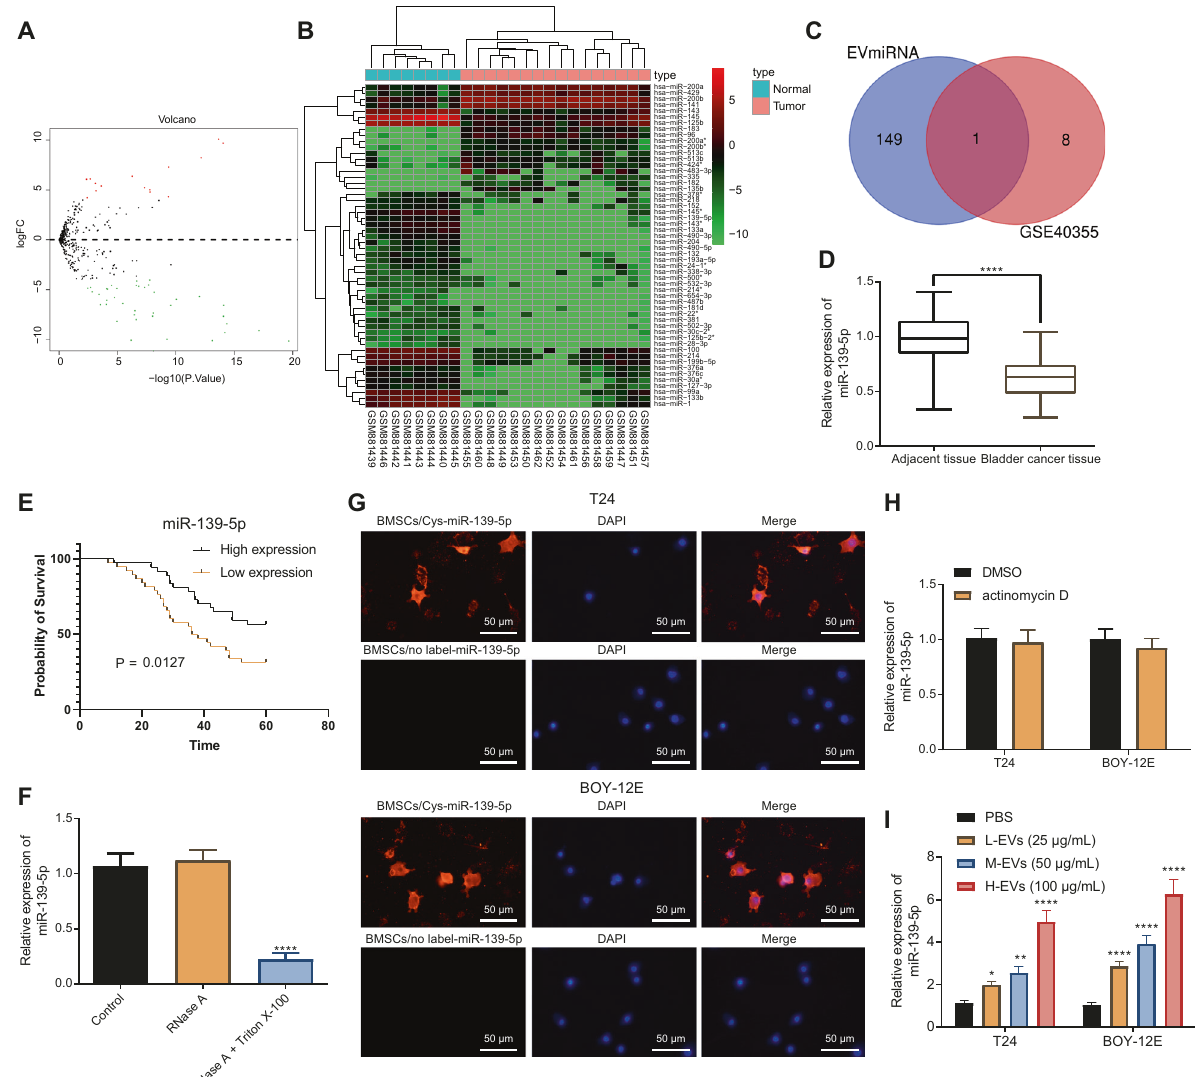
Fig. 2 BMSCs-EVs deliver miR-139-5p into bladder cancer cells. A A volcano map of miRNA differential expression in the GSE40355 dataset. The black part indicates the miRNA with no signi fi cant difference in bladder cancer, the green represents the miRNA that was signi fi cantly downregulated in bladder cancer, and the red represents the miRNA that was signi fi cantly upregulated in bladder cancer. B A heat map of expression of the 15 most signi fi cantly upregulated and 39 most downregulated miRNAs in the GSE40355 dataset. C Screening of miRNAs that were signi fi cantly downregulated in bladder cancer and expressed in BMSCs-EVs. The left circle represents the top 150 miRNAs of EVmiRNA query results, the right circle represents the top 10 miRNAs signi fi cantly downregulated in GSE40355 dataset, and the middle part represents the intersection of the two groups of data. D The expression of miR-139-5p in bladder cancer tissues and the adjacent normal tissues measured using RT-qPCR ( n = 75). **** p < 0.0001. E The relationship between the survival rate of bladder cancer patients and miR-139-5p expression in bladder cancer tissues analyzed by the Kalpan-Meier method ( n = 75). F The expression of miR-139-5p in the BMSC culture medium after the addition of RNase A alone or RNase A and Triton X-100 co-addition to treat EVs tested using RT-qPCR. **** p < 0.0001. G The uptake of Cy3-labeled BMSCs-EVs-miR-139-5p (red fl uorescence) by T24 and BOY-12E cells was observed by a fl uorescence microscope. The cytoplasm stained with DAPI shows blue (Scale bar = 50 μ m). H The expression of miR-139-5p in T24 and BOY-12E cells after actinomycin D treatment monitored by RT-qPCR. I The expression of miR-139-5p in T24 and BOY-12E cells co-cultured with different concentrations of EVs detected by RT-qPCR. The measurement data were expressed as mean ± standard deviation. Paired t test was conducted to compare data between the cancer tissues and adjacent normal tissues. Unpaired t test was performed for a two-group data comparison. One-way ANOVA was conducted for multi-group data comparison, followed by Tukey ’ s post hoc test. * p < 0.05, ** p < 0.01, or **** p < 0.0001, vs. PBS group or RNase A group. The cell experiment was repeated three times